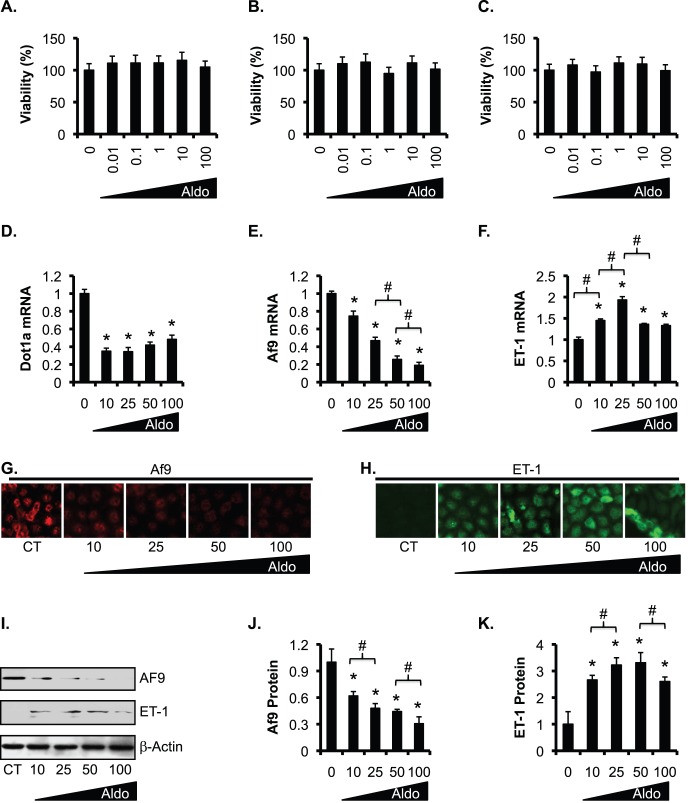
Complex dosage effects of aldosterone on downregulation of Dot1a and Af9 and upregulation of ET-1 in NRK-52E cells. (A–C) NRK-52E cells were treated with ethanol as vehicle control (0) or 10–100 nM aldosterone (Aldo) and analyzed by MTT assay for cell viability at 24 h (A), 48 h (B), and 72 h (C). n = 3. In all cases, *P<0.05 vs. CT. (D–F) NRK-52E cells were treated as in A for 24 h, and analyzed by RT-PCR for mRNA expression of the genes indicated. n = 3–6. (G–H) Representative IF images showing Af9 and ET-1 expression. (I) Representative IBs showing expression of Af9 and ET-1. Additional CT and aldosterone-treated samples were analyzed and shown in Fig. 8. Note, all samples received the same amount of ethanol as vehicle control. (J–K) The intensity of each band in I was analyzed as in Fig. 5E–F. n = 3–6. In all cases, *P<0.05 vs. CT. #P<0.05 as shown. For simplicity, comparison between aldosterone-treated cells was limited to the adjacent two doses.